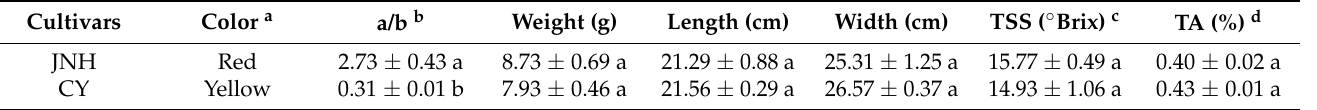
Table 2. The morphological trait and quality index value of the cultivars’ fruit in the fully mature